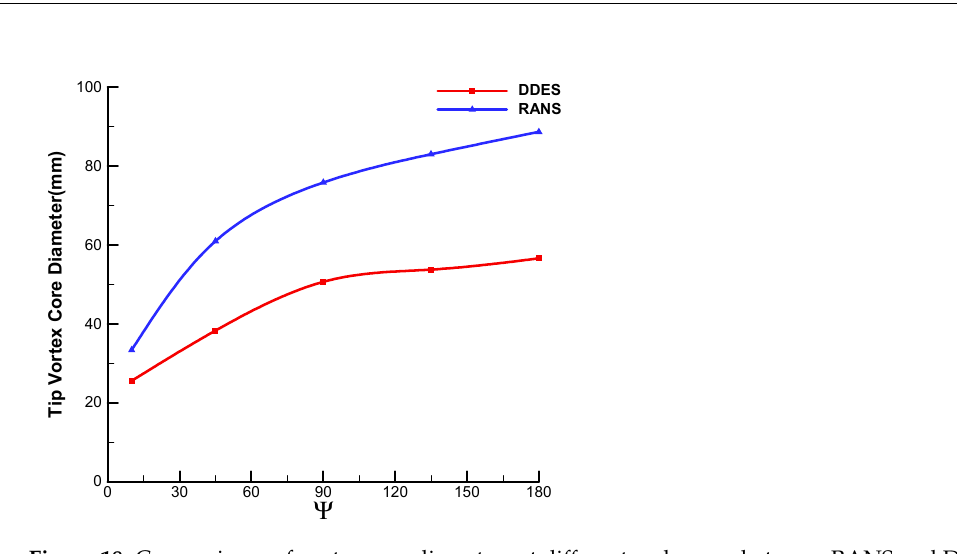
Figure 18. Comparisons of vortex core diameters at different wake ages between RANS and DDES.